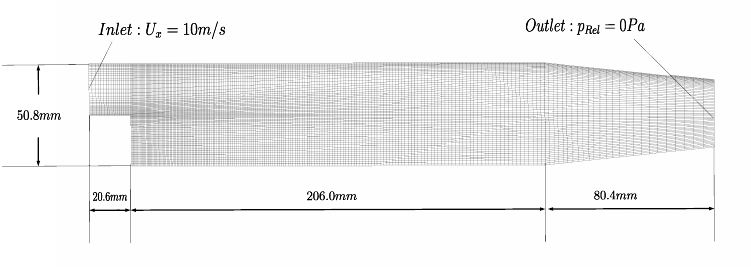
Figure 5. The mesh used in the test case of